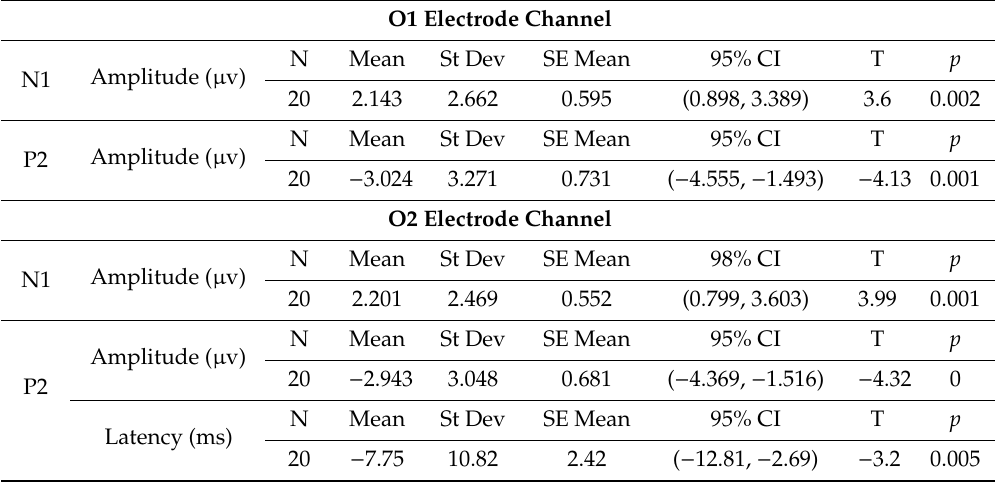
Table 2. Amplitude and latency di ff erences of N and P components of visual ERP waves evoked by Pattern